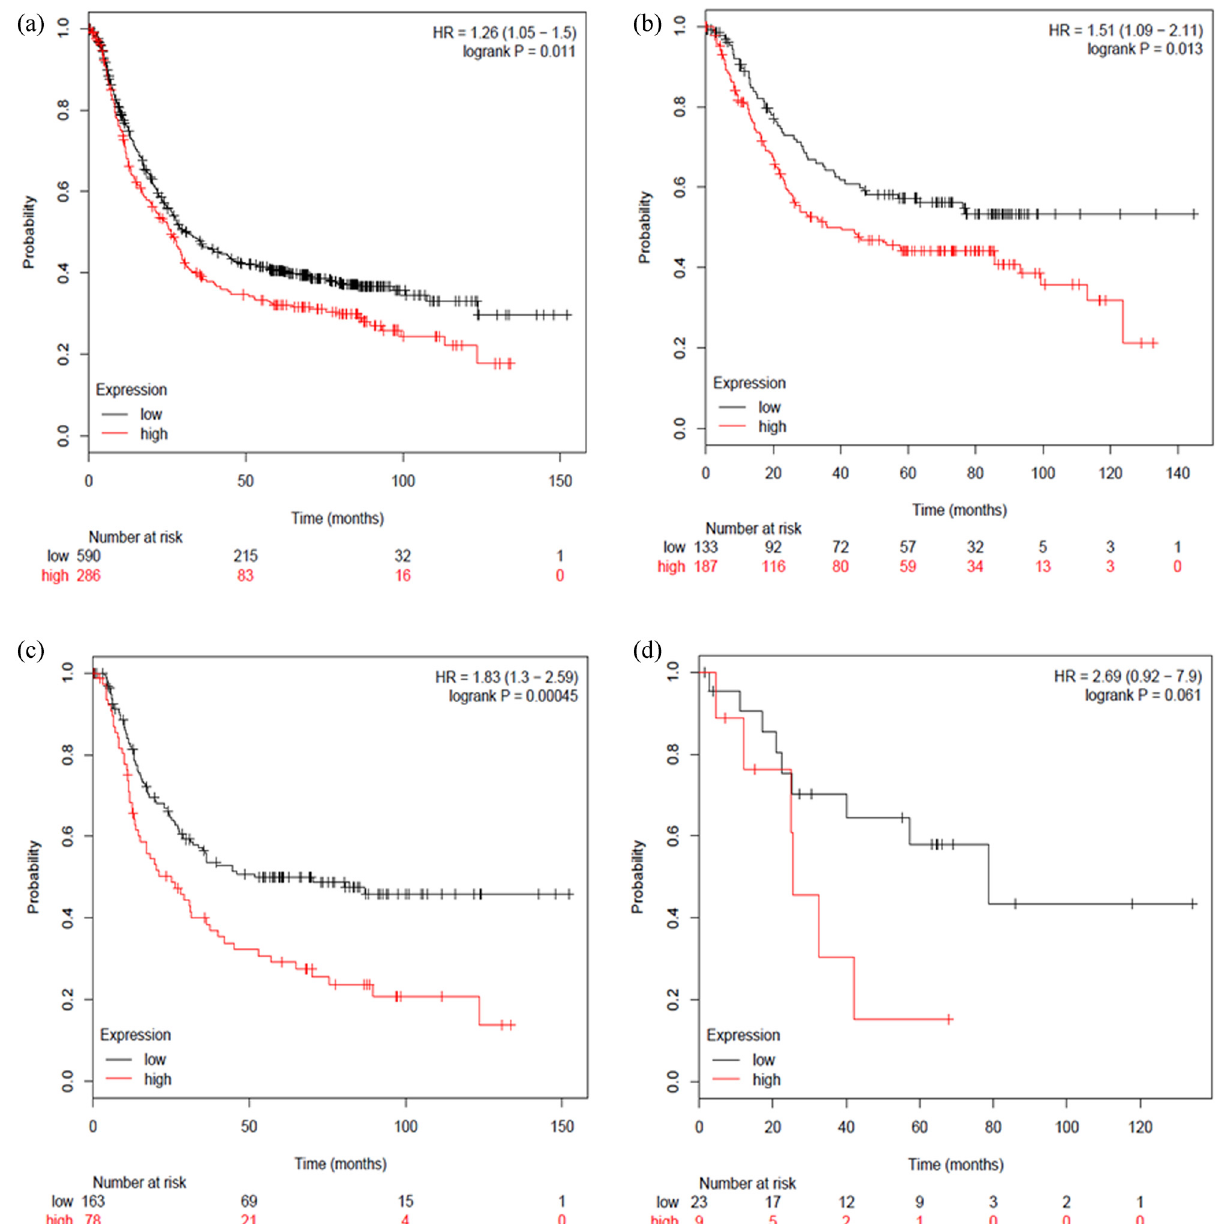
Figure 2: Determination of the prognostic value of ROR α mRNA expression using www.kmplot.com. The desired A ff ymetrix ID is valid: 210479_s_at ( ROR α ) . ( a ) Survival curves were plotted for all patients with GC ( n = 876 ) . ( b ) Survival curves were plotted for patients with intestinal - type GC ( n = 320 ) . ( c ) Survival curves were plotted for patients with di ff use - type GC ( n = 241 ) . ( d ) Survival curves were plotted for patients with mixed - GC ( n = 33 )